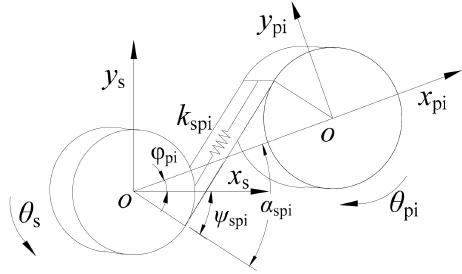
Figure 3. External meshing element.